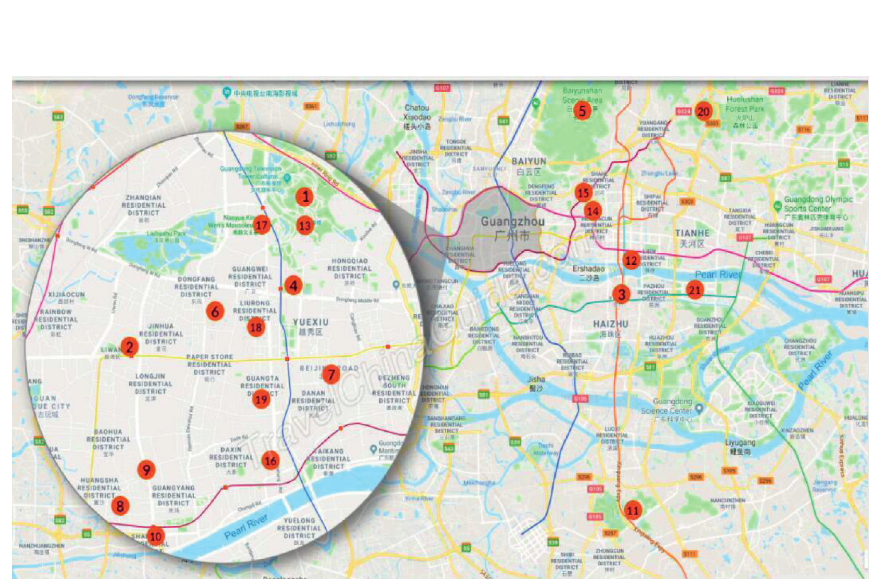
Figure 2: Customer location information map in Guangzhou (brown